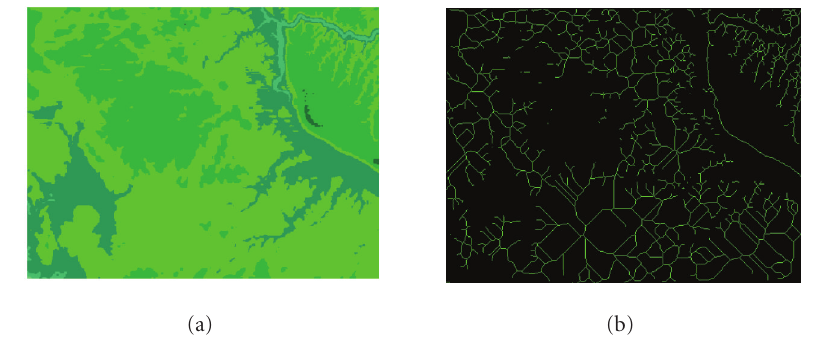
Figure 5.1. Implementation of the DEM smoothening algorithms on the DEM of Lake Mary (a) The DEM of Lake Mary, (b) The channel network of the DEM.